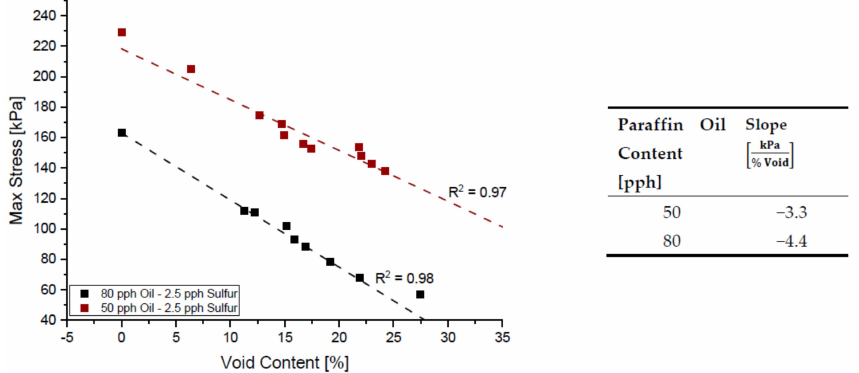
Figure 23. The influence of paraffin oil content on σ relax of NR blend with 2.5 pph of sulfur.